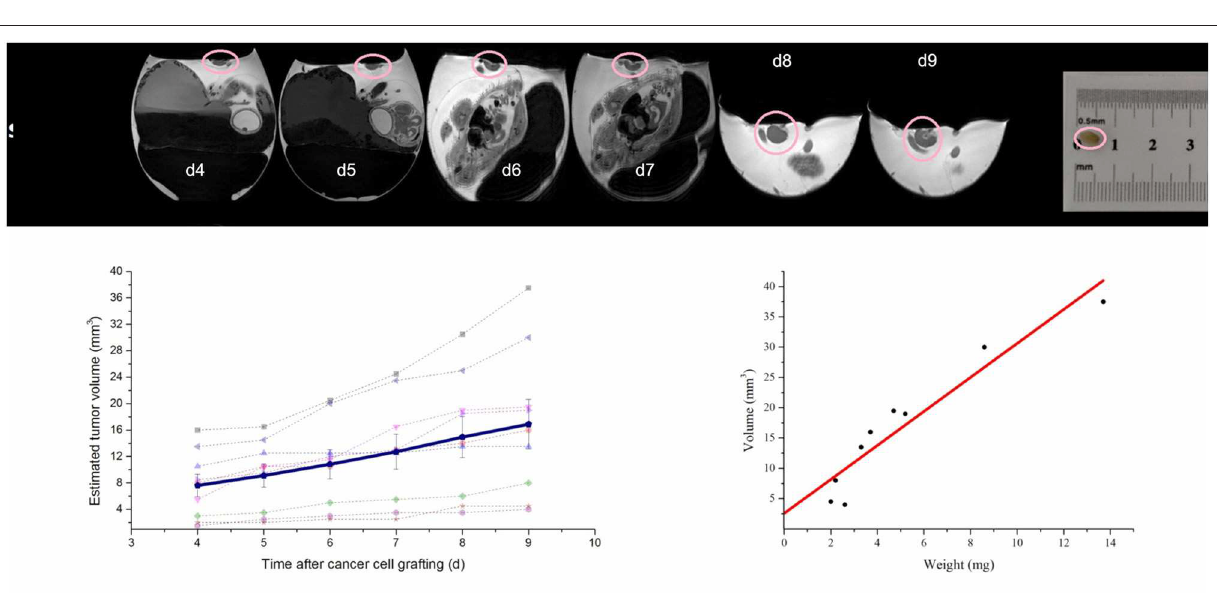
Frontiers in Physics | www.frontiersin.org